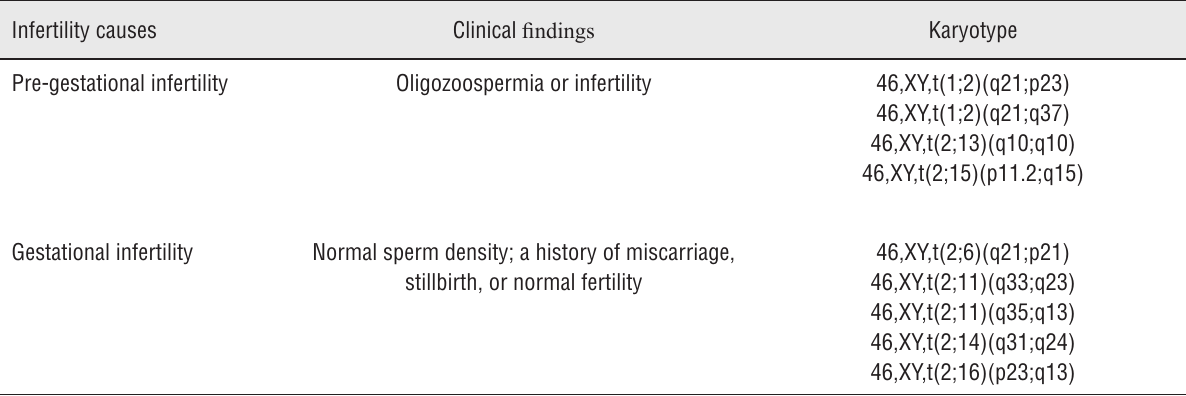
Table 1 - Karyotypes of chromosome 2 translocation carriers and their clinical features. Infertility causes Clinical findings